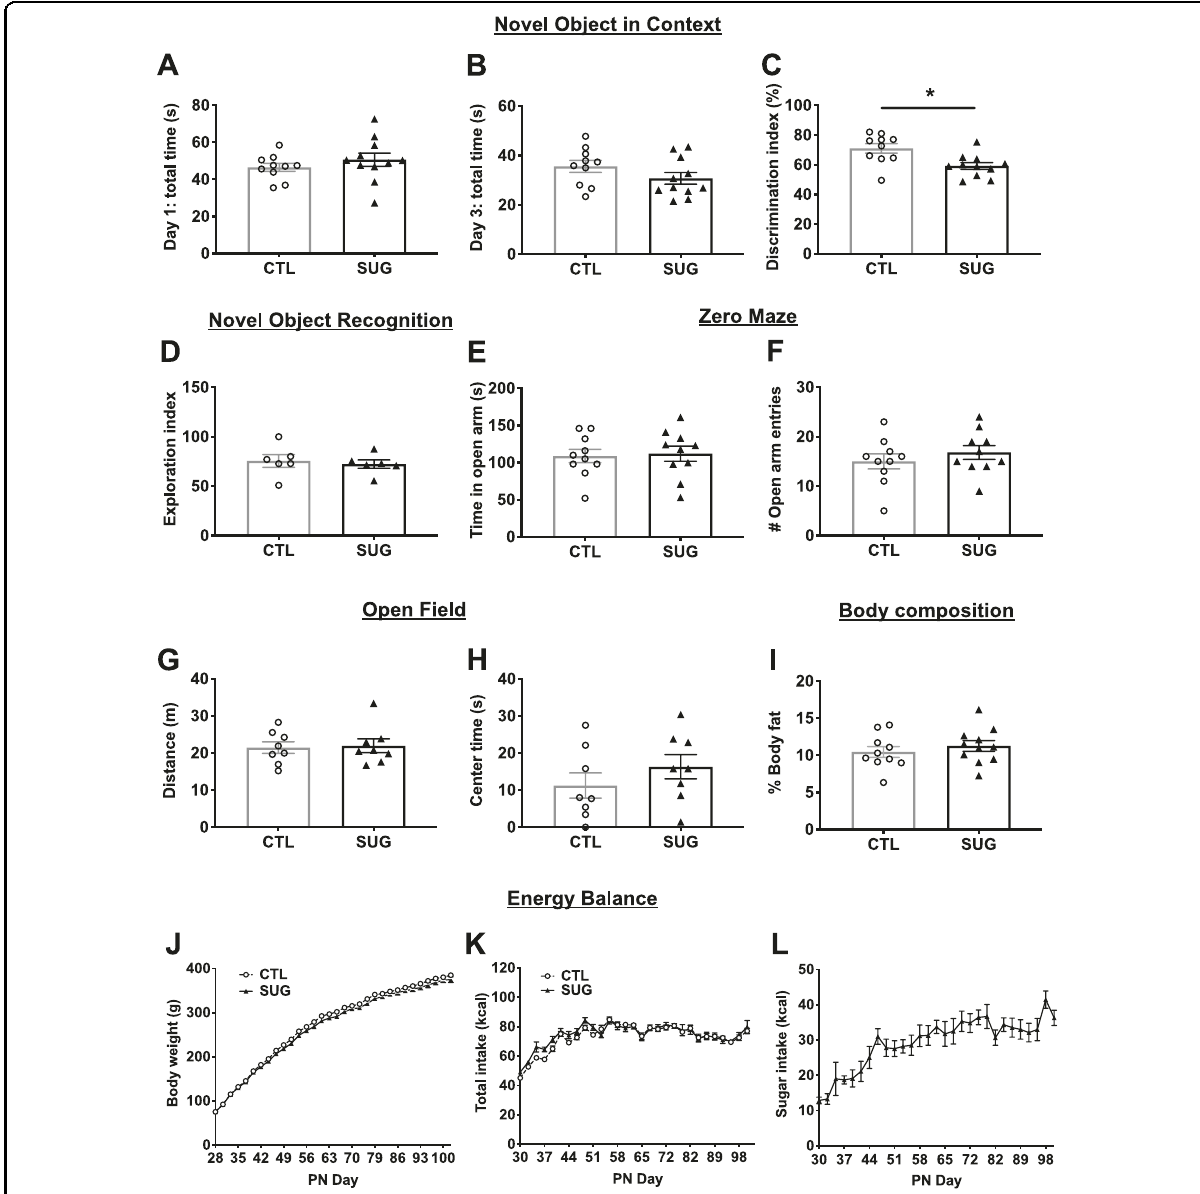
Fig. 1 Early life sugar consumption negatively impacts hippocampal-dependent memory function. A , B Early life sugar consumption had no effect on total exploration time on days 1 (familiarization) or day 3 (test day) of the Novel Object in Context (NOIC) task. C The discrimination index was signi fi cantly reduced by early life sugar consumption, indicating impaired hippocampal function ( P <0.05, n = 10,11; two-tailed, type 2 Student ’ s t test). D There were no differences in exploration index in the Novel Object Recognition (NOR task) ( n = 6; two-tailed, type 2 Student ’ s t test). E , F There were no differences in time spent in the open arm or the number of entries into the open arm in the Zero Maze task for anxiety-like behavior ( n = 10; two-tailed, type 2 Student ’ s t test). G , H There were no differences in distance traveled or time spent in the center arena in the Open Field task ( n = 8; two-tailed, type 2 Student ’ s t test). I There was no differences in body fat % during adulthood between rats fed early life sugar and controls ( n = 10,11; two-tailed, type 2 Student ’ s t test). J , K Body weights and total energy intake did not differ between the groups ( n = 10,11; two-way repeated-measures ANOVA), despite ( L ) increased kcal consumption from sugar-sweetened beverages in the sugar group. CTL = control, SUG = sugar, PN = post-natal day; data shown as